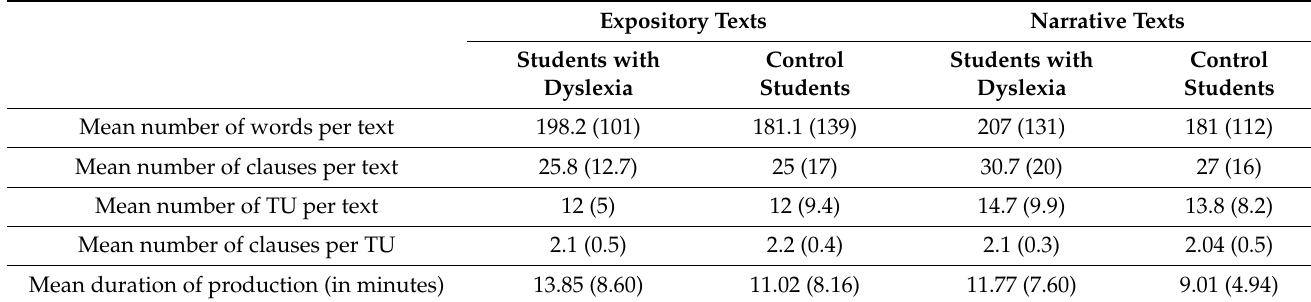
Table 2. Length indicators for written texts according to text type and group. Expository Texts Narrative Texts Students with Control Students with Dyslexia Students Dyslexia